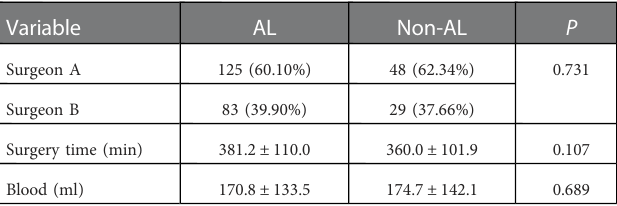
TABLE 2 Intraoperative parameters of 285 patients with minimally invasive McKeown esophagectomy. Variable